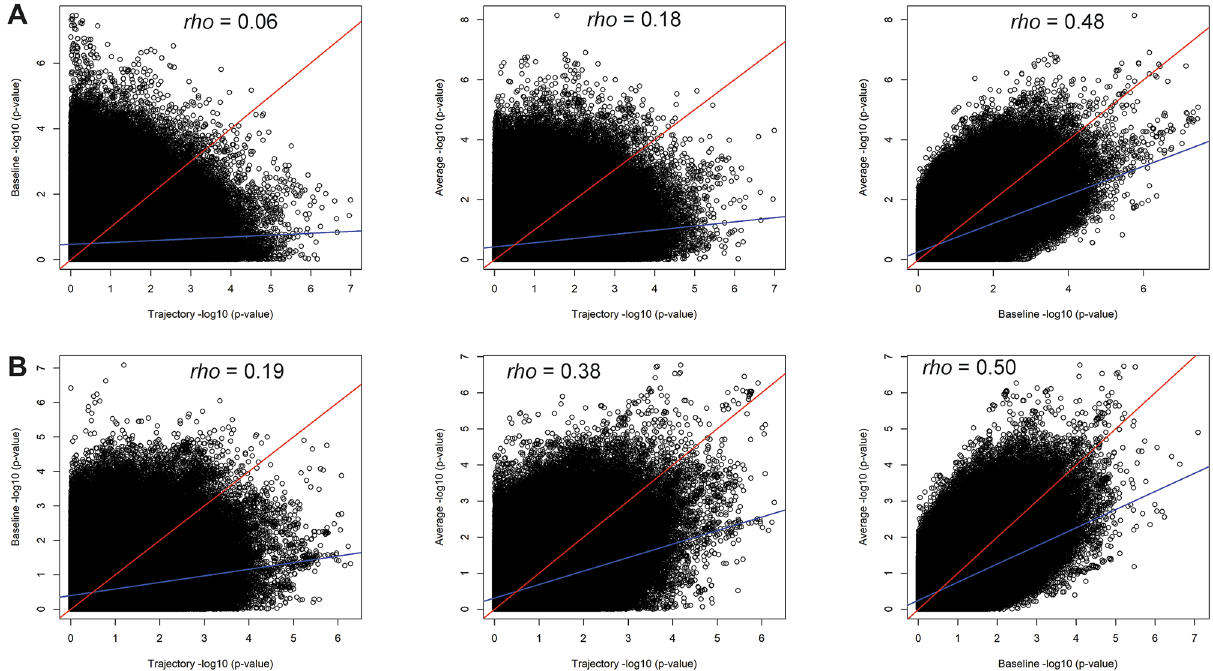
Figure 2. Comparison between longitudinal and cross-sectional SBP data. Correlation between the meta- analysis results using ( A ) African American and ( B ) European American data. We combined 5293 African Americans and 13,120 European Americans from the ARIC, MESA, and HABC studies (Table 1). We used ~ 20 million variants tested for association among African Americans and ~ 10 million variants for European- Americans. The blue lines represent the fitted linear regressions and the red lines represent the x = y line. All correlations had p ≤ 2.2 × 10 −16